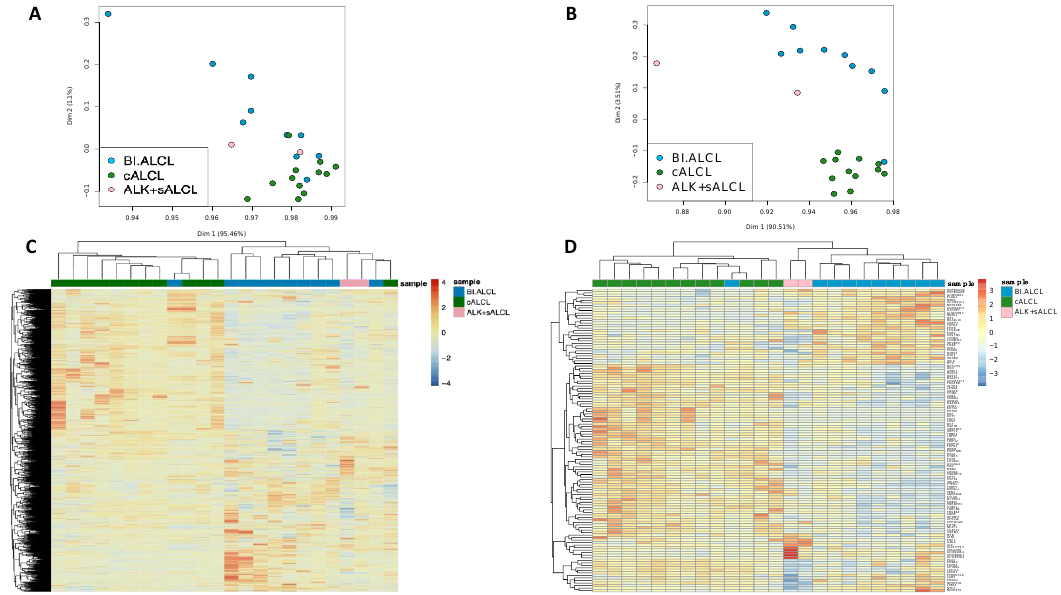
Figure 3. Unsupervised and supervised analyses of cALCLs, BI-ALCLs and ALK+ sALCLs. Principal component analysis ( A , B ) and hierarchical clustering ( C , D ) of all entities by cell type (( B , D ) one-way ANOVA (BH-adjusted p -values < 0.05)). Among the 148 differentially expressed genes (DEGs) ( t -test, BH-adjusted p value < 0.05) (40 genes upregulated in BI-ALCLs and 108 upregulated in cALCLs) that neatly sep- arated BI-ALCLs and cALCLs (Figure 4, Table S2), WT1 was among the top-10 upregu- lated DEGs in BI-ALCLs ( p = 9.1 × 10 − 5 , fold change 4.78). To validate this at the protein level, we immunostained eight BI-ALCL, four cALCL and two ALK+ sALCL samples for WT1. In all eight BI-ALCLs, most of the tumor cells showed nuclear and occasional cyto- plasmic staining, whereas the cALCL and ALK+ sALCL samples were negative (Figure 5).